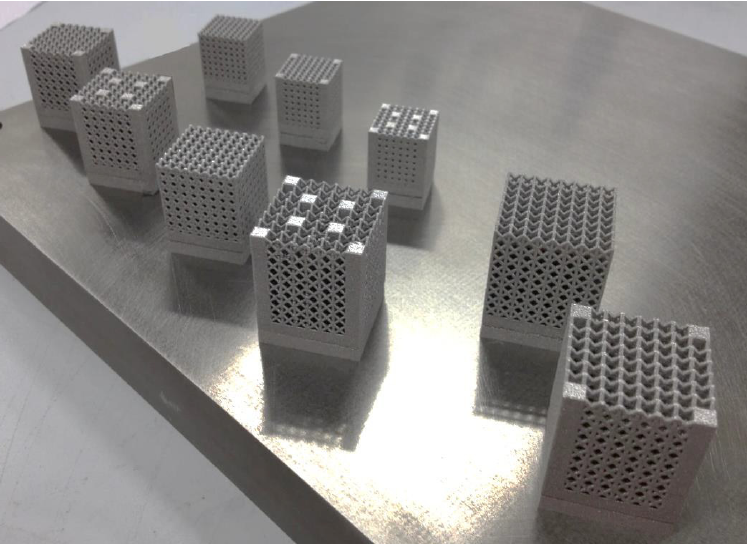
Figure 1. Samples on the building platform.